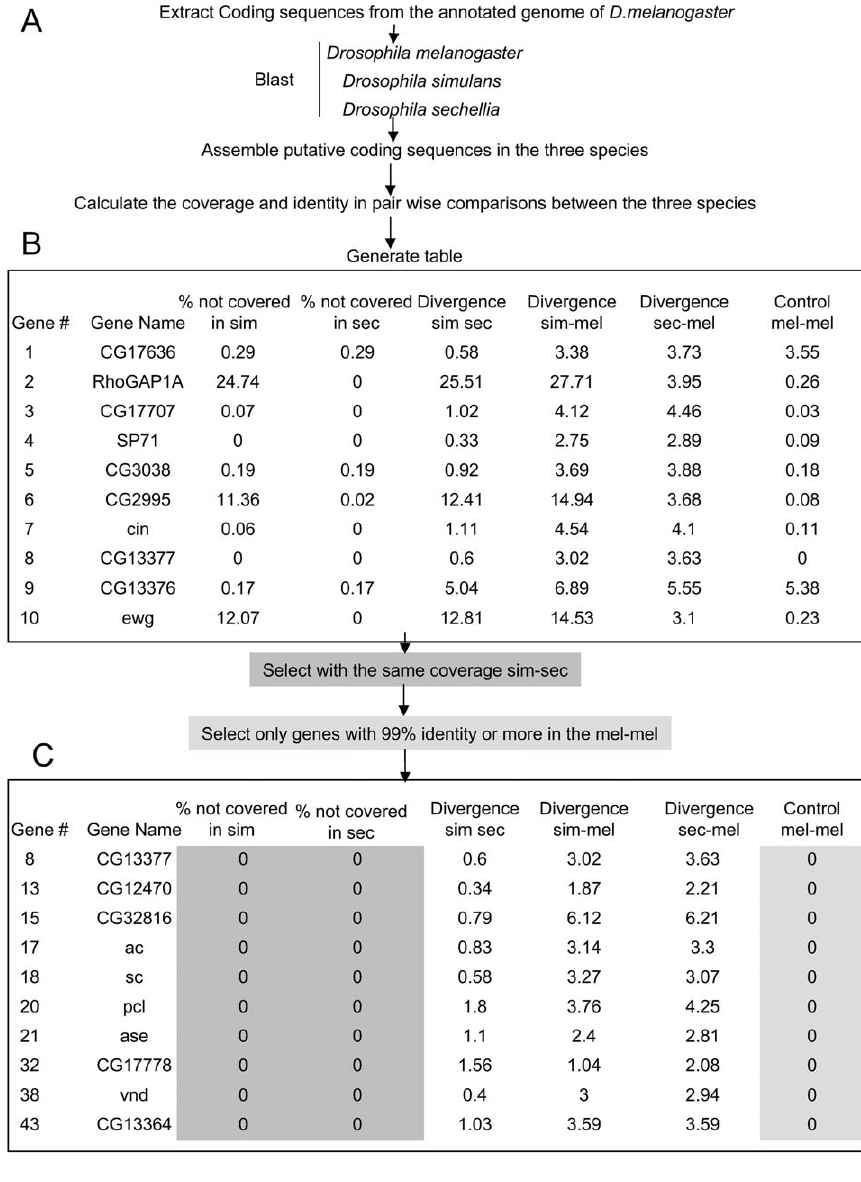
Figure 1. Overview of the data collection and sorting. A) Exons of coding sequence were extracted from the annotated genome of D. melanogaster using Extractor and electronically joined using Analyst to obtain complete coding sequences. These coding sequences were then automatically blasted against the genome of D. melanogaster , D. simulans and D. sechellia with Megablast. Analyst scanned the resulting alignments for the best hits and assembled the coding sequences in the three species from them. B) Analyst also calculated the coverage, the percentage not covered, the divergence in sim-sec, sim-mel, sec-mel as well as the control mel-mel and organized this data in a table. C) To minimize artifacts due to incomplete clone representation in the genomic libraries, the coding sequences were filtered and only genes with the same coverage in D. simulans and D. sechellia retrieved. To avoid genes truncated by Megablast (i.e. usually genes with small exons), only genes with a mismatch up to 1% in the control mel-mel were retrieved. After these two filters were applied, a new table like the one exemplified in C) was generated for each chromosome.